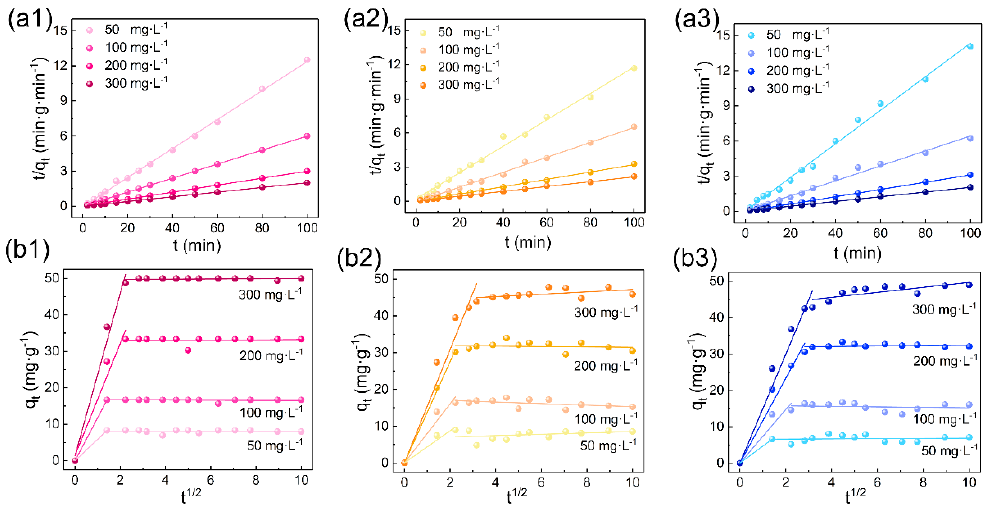
Figure 8. Pseudo-second order kinetics for the adsorption of ( a1 ) RR120, ( a2 ) RY167, and ( a3 ) RB222 onto the CL powders, respectively (m = 0.3 g, V = 50 mL, C 0 = 50, 100, 200, and 300 mg·L − 1 , T = 30 °C, pH = 3.0); intraparticle diffusion kinetics for the adsorption of ( b1 ) RR120, ( b2 ) RY167, and ( b3 ) RB222 onto the CL powders, respectively (m = 0.3 g, V = 50 mL, C 0 = 50, 100, 200, and 300 mg·L − 1 , T = 30 °C, pH = 3.0). Table 2. Kinetic parameters of the pseudo-first order and pseudo-second order kinetic models for the adsorption of RR120, RY167, and RB222 onto the CL powders.